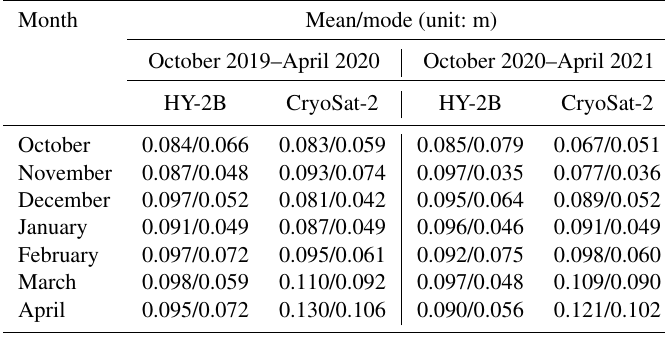
Table 4. Differences in the monthly mean radar freeboard values of HY-2B and CryoSat-2 on FYI, MYI and total sea ice. Month Unit: m FYI MYI ALL